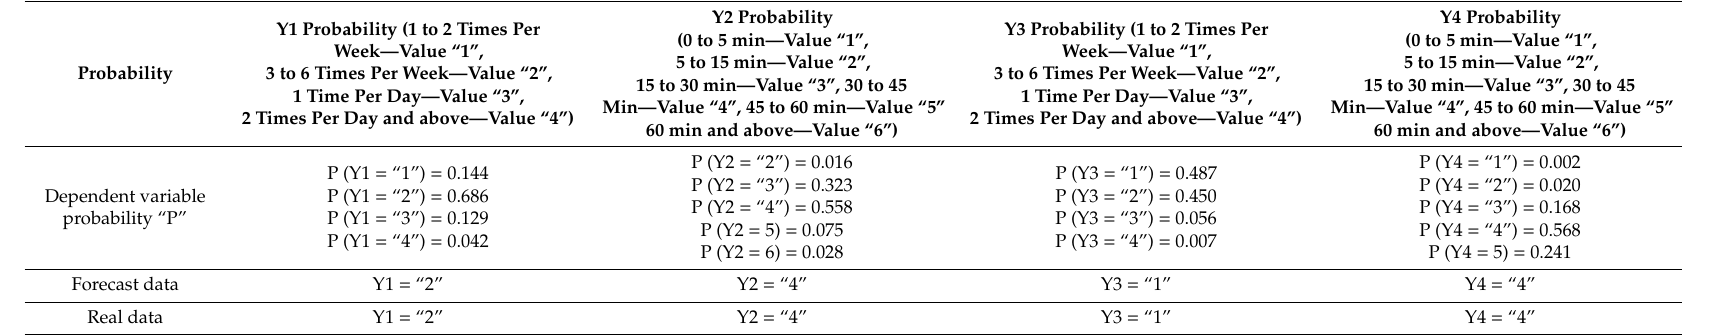
Table 9. Comparison of model prediction data and real